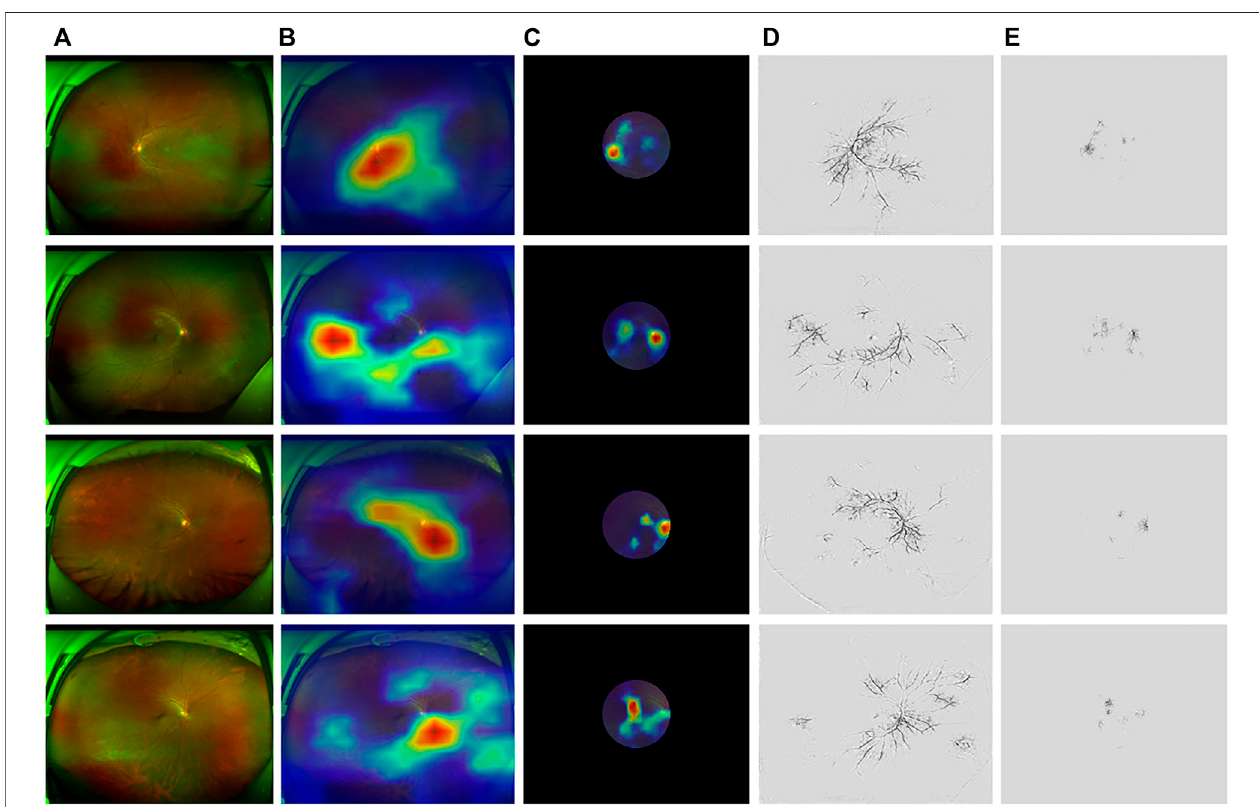
FIGURE 5 | Examples applying GradCAM and Guided-Backpropagation to highlight the region ’ s model while focusing on predicting. (A) Original UWF fundus images. The region in the red circle is the same as cropped images. (B,C) Saliency maps of ASModel_UWF and ASModel_CroppedUWF from GradCAM covering the original and cropped UWF images, respectively. (D,E) Saliency maps of ASModel_UWF and ASModel_CroppedUWF from Guided-Backpropagation, respectively. The toptworowswerenormalsubjects(64 yearsold,male,17 g/dl;12 yearsold,male,14.1 g/dl),whilethebelowtworowswereanemiapatients(58 yearsold,male, 8.6 g/dl; 44 years old, female, 10.2